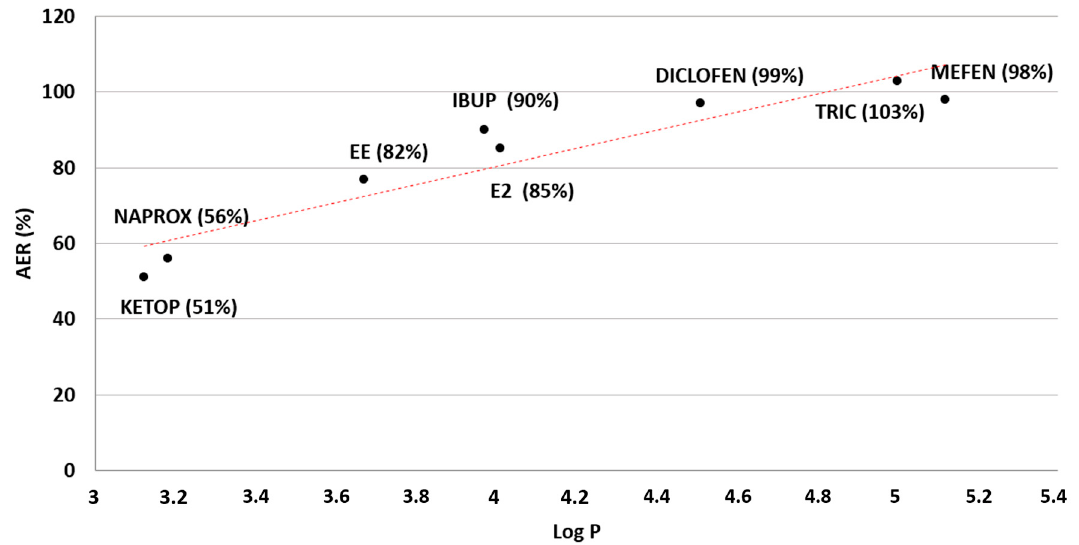
Figure 3. Effect of the target analyte hydrophobicity (LogP) in the absolute extraction recovery (expressed as %) in aqueous samples for N , N -Dimethylcyclohexylamine (DMCA) as extractant SHS.